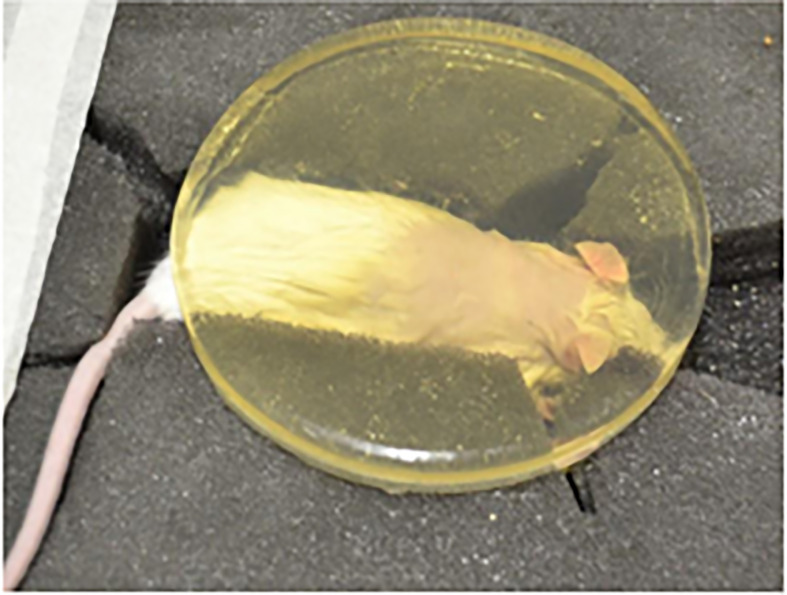
A Swiss albino mouse in ventral recumbence in the foam bed, with the acoustic solid gelatin on him.